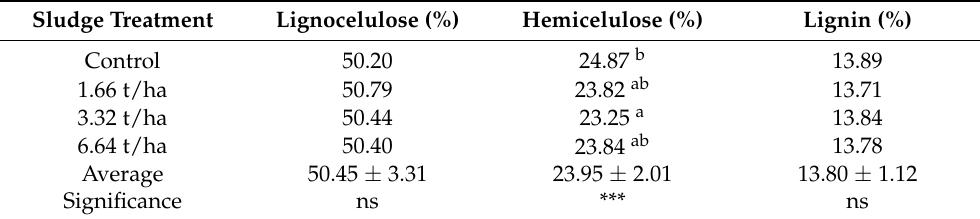
Values are the mean ± SD of three replicates. Different letters in each row indicate significant difference at p ≤ 0.05 by Tukey’s HSD test. Values without letters are not significantly different. Significance: *** p < 0.001; ns,